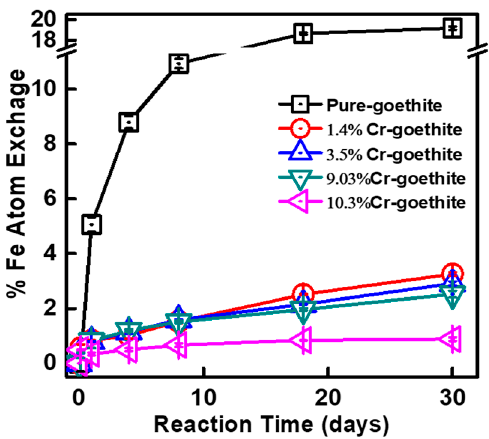
Figure 5. Changes in Fe atom exchange rates during the Fe(II) aq -induced recrystallization of pure goethite, 1.4% Cr-goethite, 3.5% Cr-goethite, 9.03% Cr-goethite, and 10.3% Cr-goethite over 30 days. Conditions: [Fe(II) aq ] = 1 mM, [goethite] = 2 g/L, pH 7.5 controlled with 25 mM HEPEs/KBr.